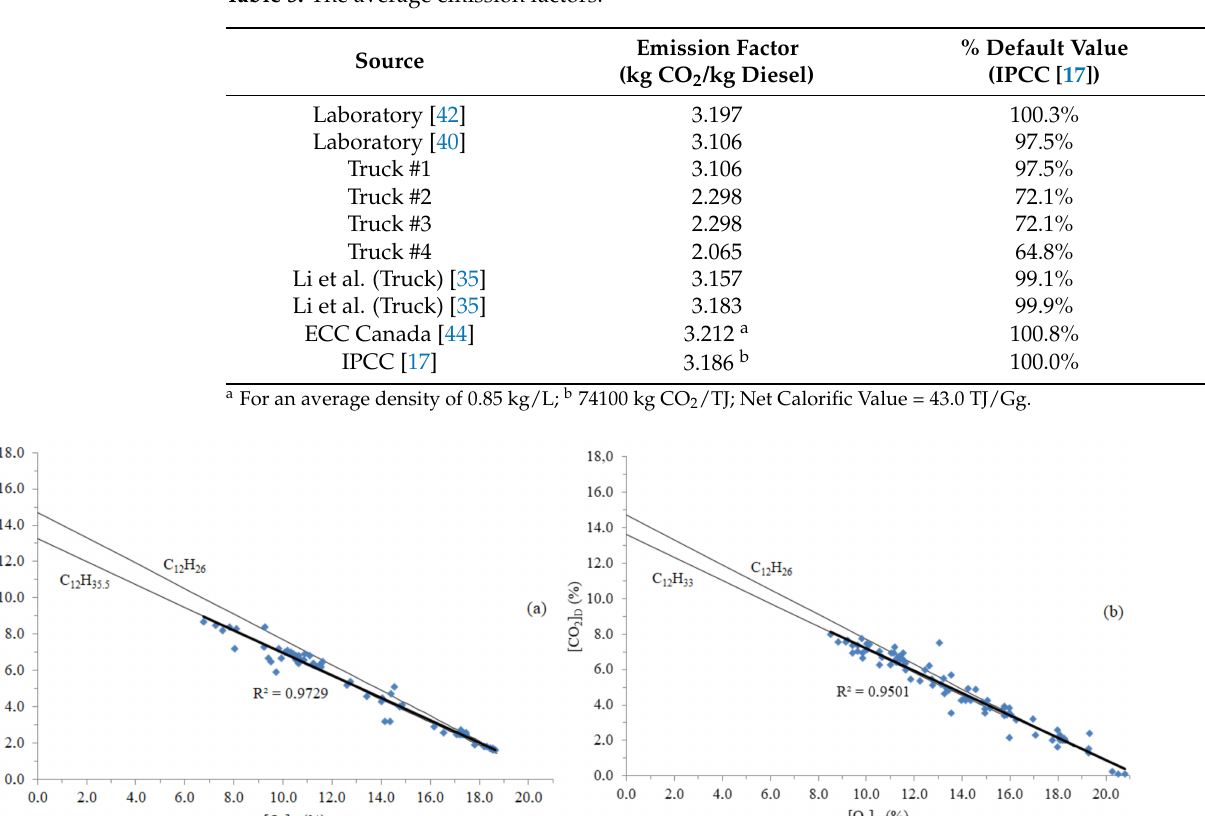
Table 5. The average emission factors.